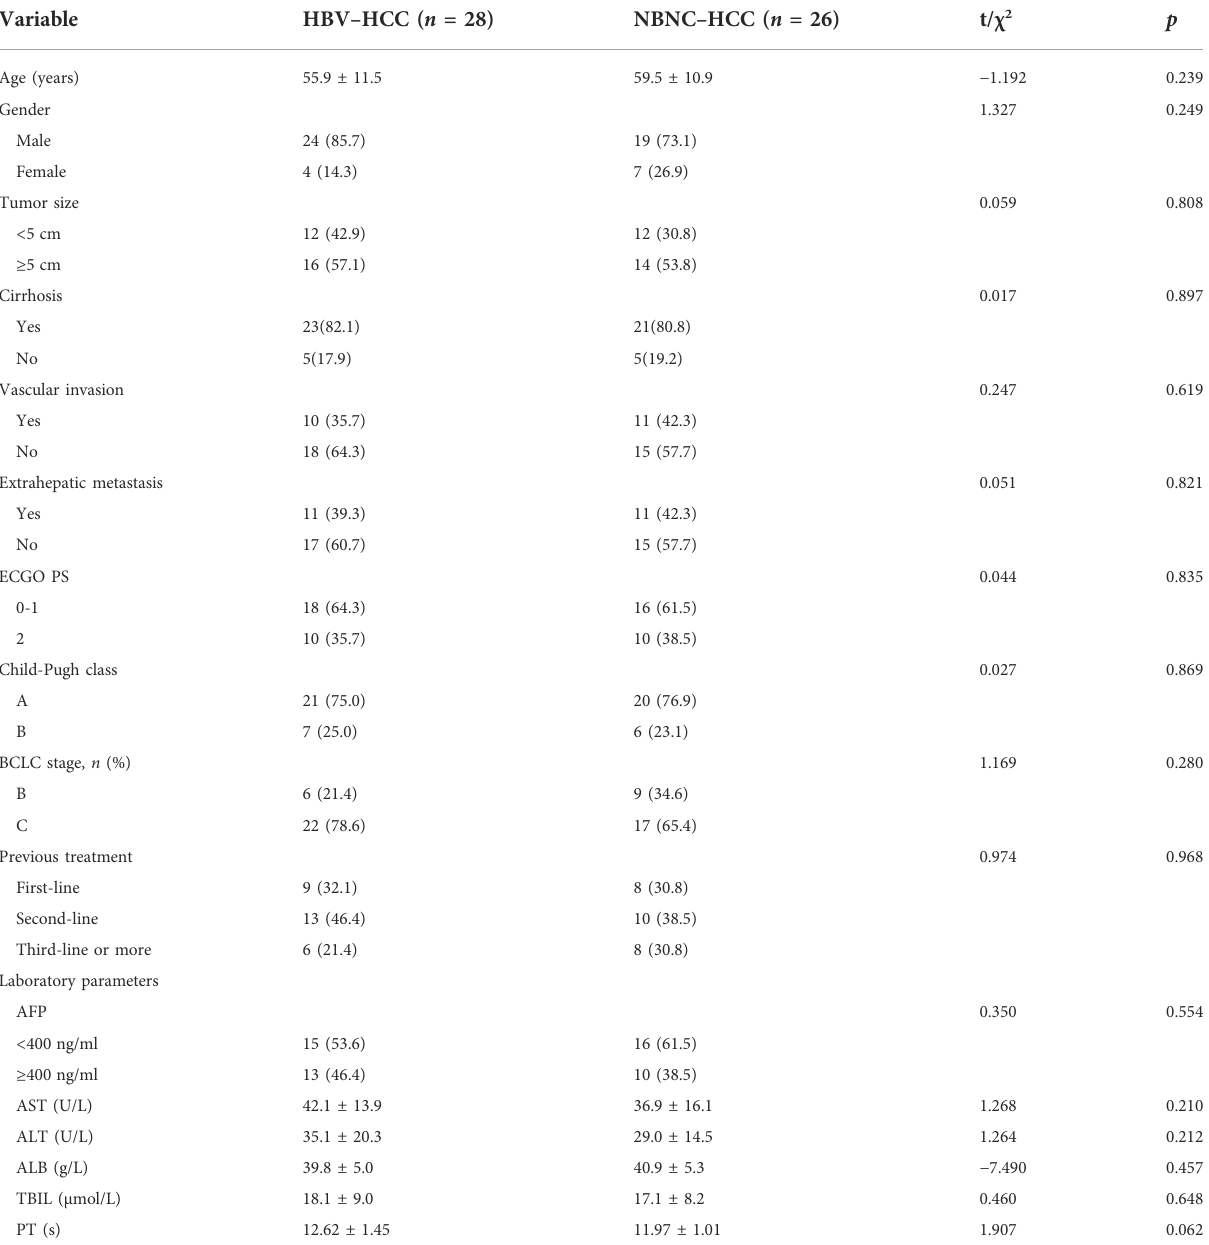
TABLE 1 Baseline characteristics of the HBV – HCC and NBNC – HCC